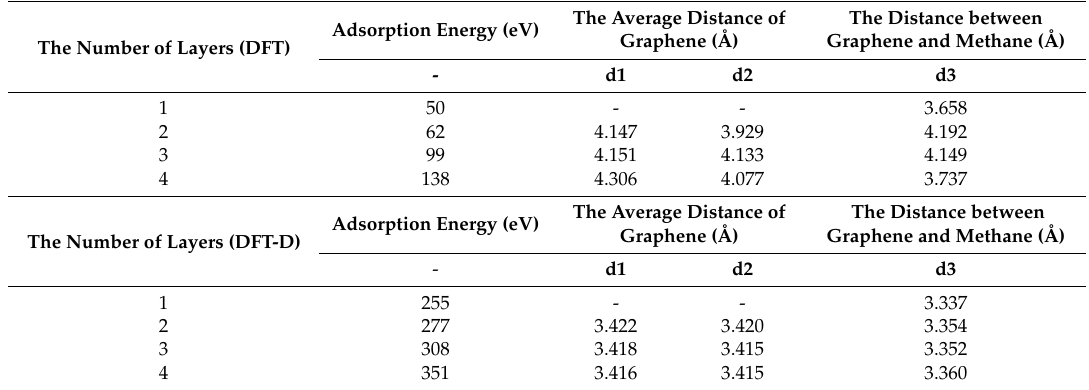
Table 1. The adsorption energy and the distances of zigzag graphene with Order stacking in the calculations of DFT and DFT-D,